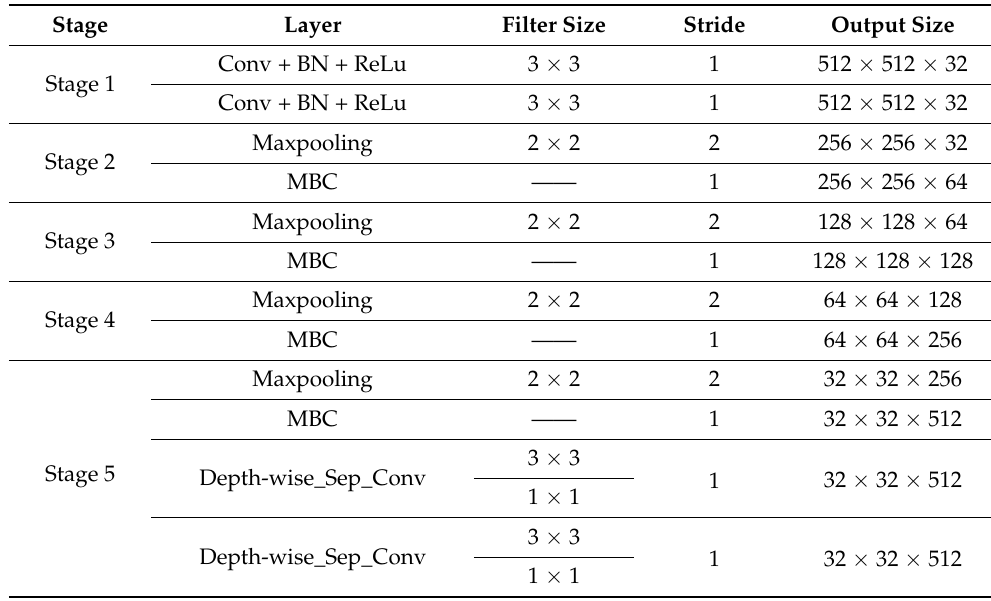
Figure 4. The structure of multi-branch convolution module. Table 1. Detailed information of the encoder.